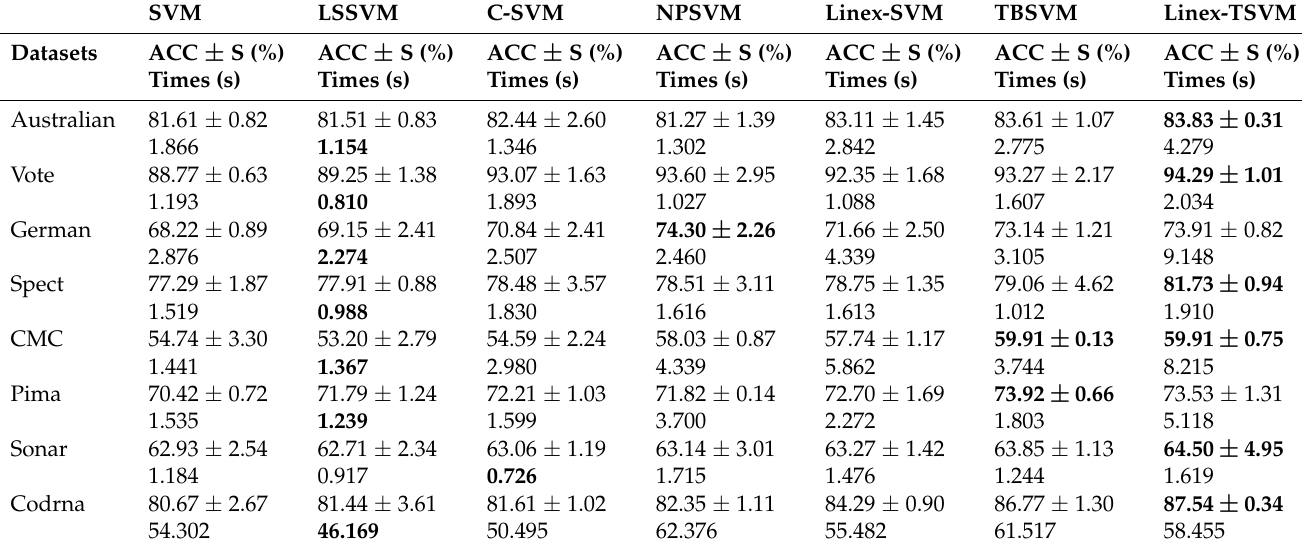
Table 3. Experimental results on UCI datasets with 10% noise.